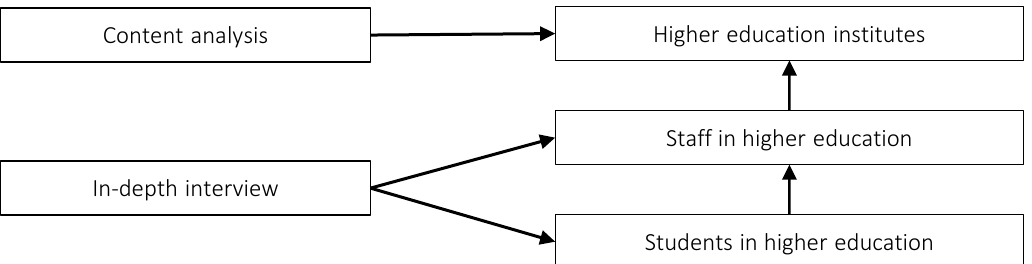
Figure 1. Bottom-up research samples and